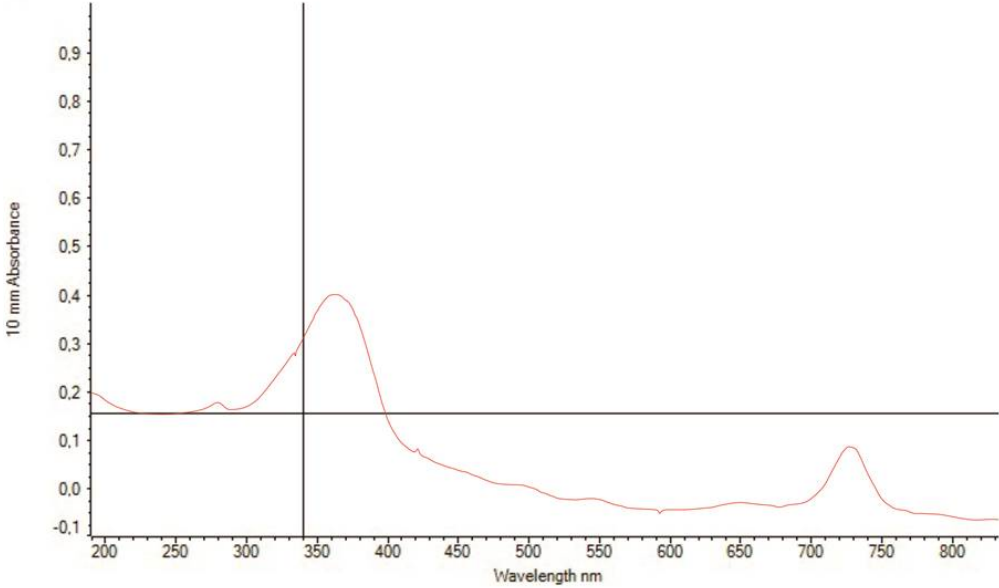
Figure 2. Ultraviolet Absorption spectrum of the ethanol extract of Sargassum crassifolium (0.1%).